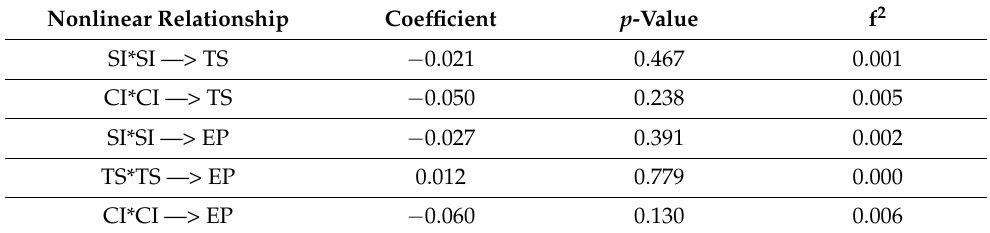
Table 7. Nonlinear effects